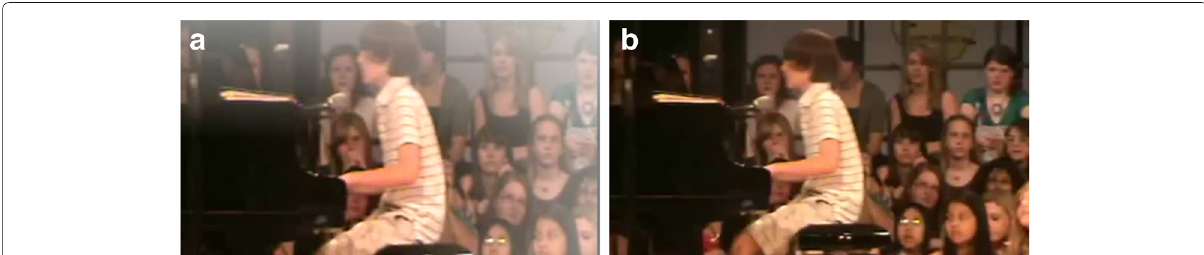
Fig.9 Video #12 . Amount of pixels hold through our method is inferior than the state-of-the-artapproach. a Adaptive Gaussianfilter; b YouTube